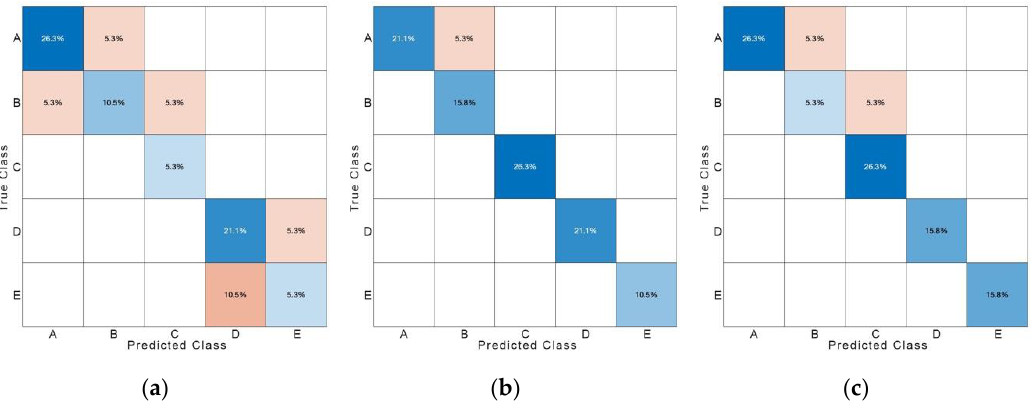
Figure 9. Confusion matrices summarizing the accuracy results for: ( a ) kNN algorithm; ( b ) decision tree model; and ( c ) Naïve Bayes classifier.